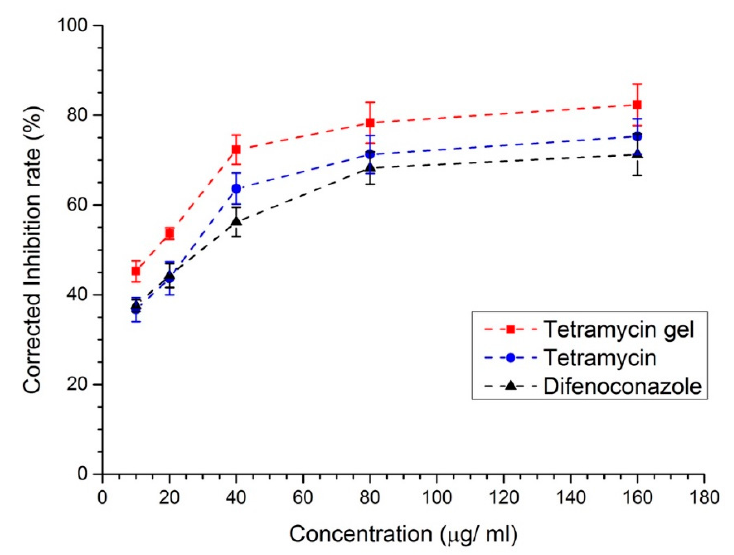
Figure 6. The corrected inhibition rate of R. solanacearum after tetramycin loaded gel, pure tetramycin, and difenoconazole was added under different concentrations at pH 5.0.